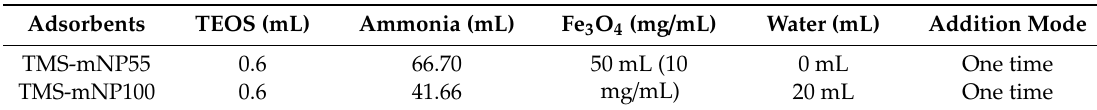
Table 4. Synthetic conditions for preparation of mNPs for functionalization. A volume of 250 mL of